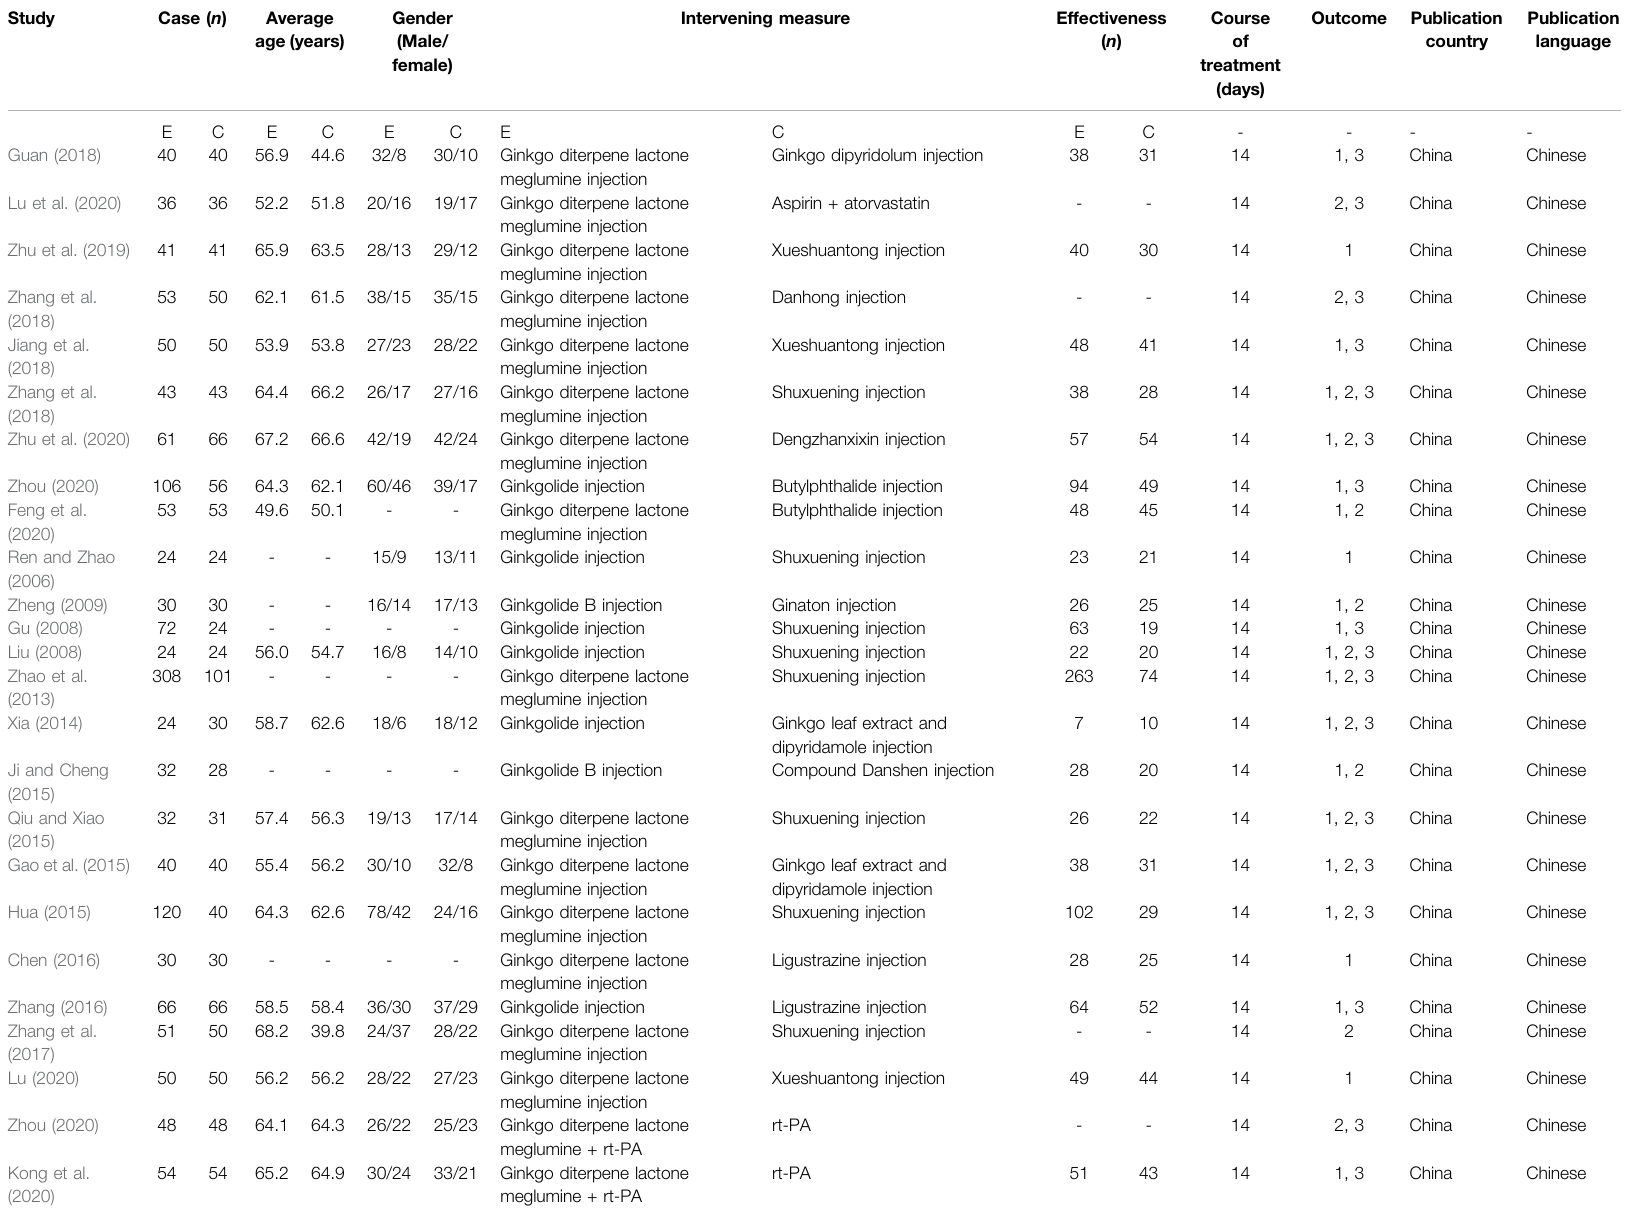
TABLE 1 | Basic characteristics of included